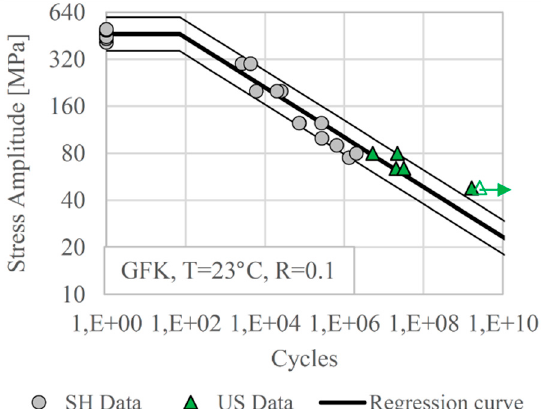
Figure 16. Fatigue data of a quasi ‐ unidirectional glass fibre ‐ reinforced polymer measured at load ratio R = 0.1 with servo ‐ hydraulic equipment at 10 Hz and ultrasonic equipment at 20 kHz; re ‐ ratio R = 0.1 with servo-hydraulic equipment at 10 Hz and ultrasonic equipment at 20 kHz; reprinted printed with permission from Elsevier [85]. with permission from Elsevier